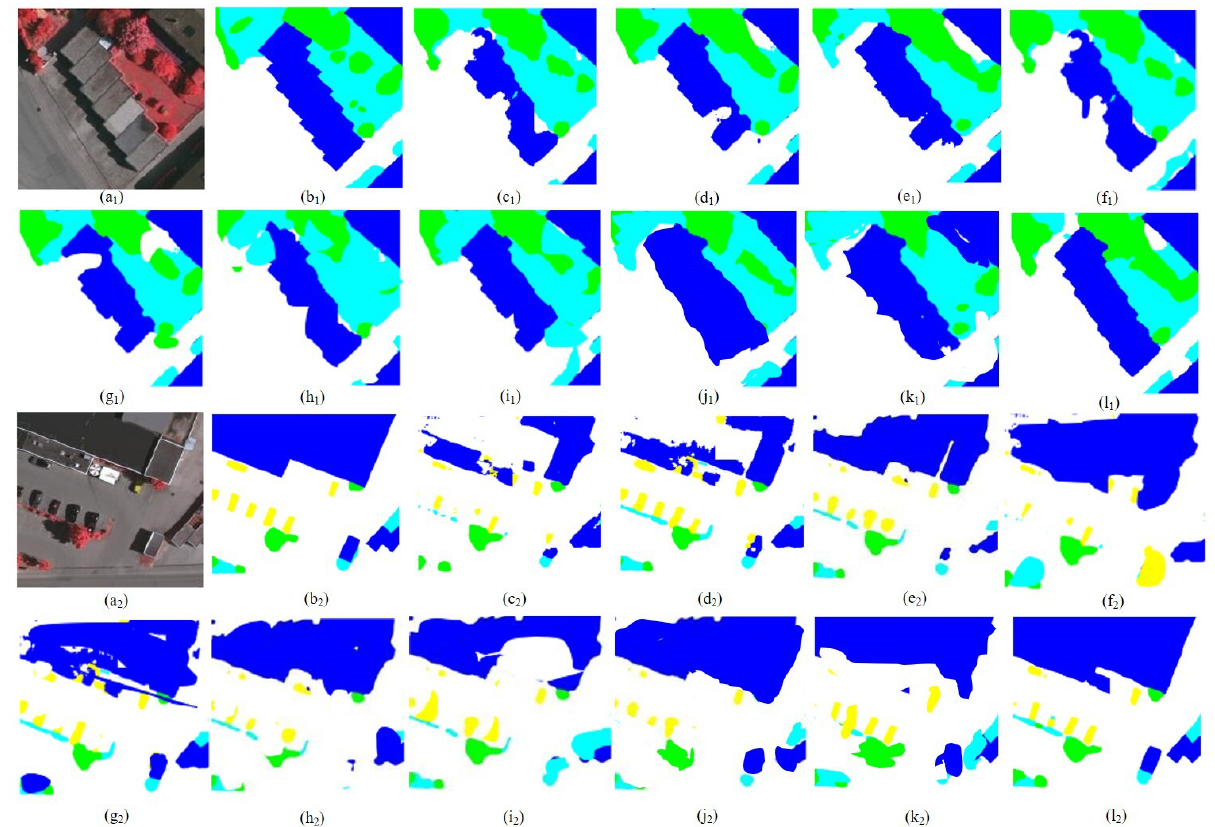
Figure 18. Semantic segmentation results on Vaihingen. ( a1 , a2 ) Original image, ( b1 , b2 ) ground truth, ( c1 , c2 ) U-Net, ( d1 , d2 ) SegNet, ( e1 , e2 ) PSPNet, ( f1 , f2 ) HRNetV2, ( g1 , g2 ) DeepLab V3+, ( h1 , h2 ) Tran- sUnet, ( i1 , i2 ) SegFormer, ( j1 , j2 ) Inception-ResNetV2, ( k1 , k2 ) Swin Transformer, and ( l1 , l2 )